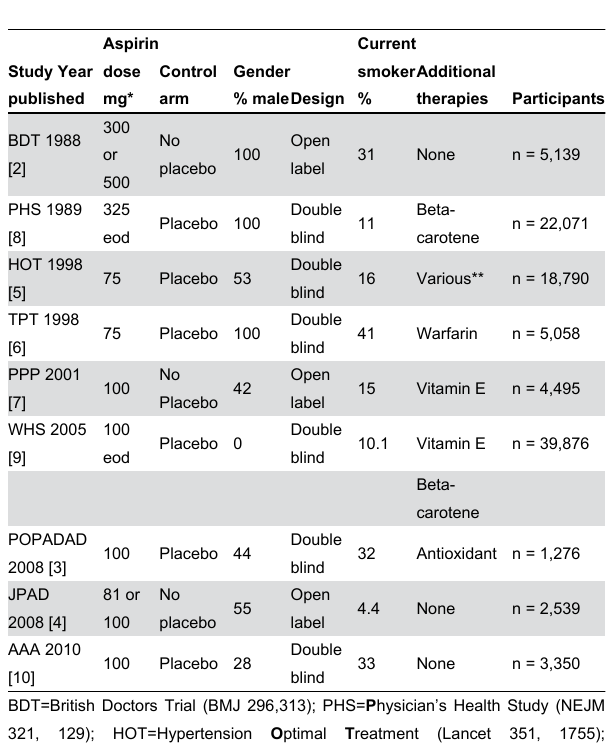
Table 1. Aspirin dose and participant characteristics in the 9 RCTs of primary